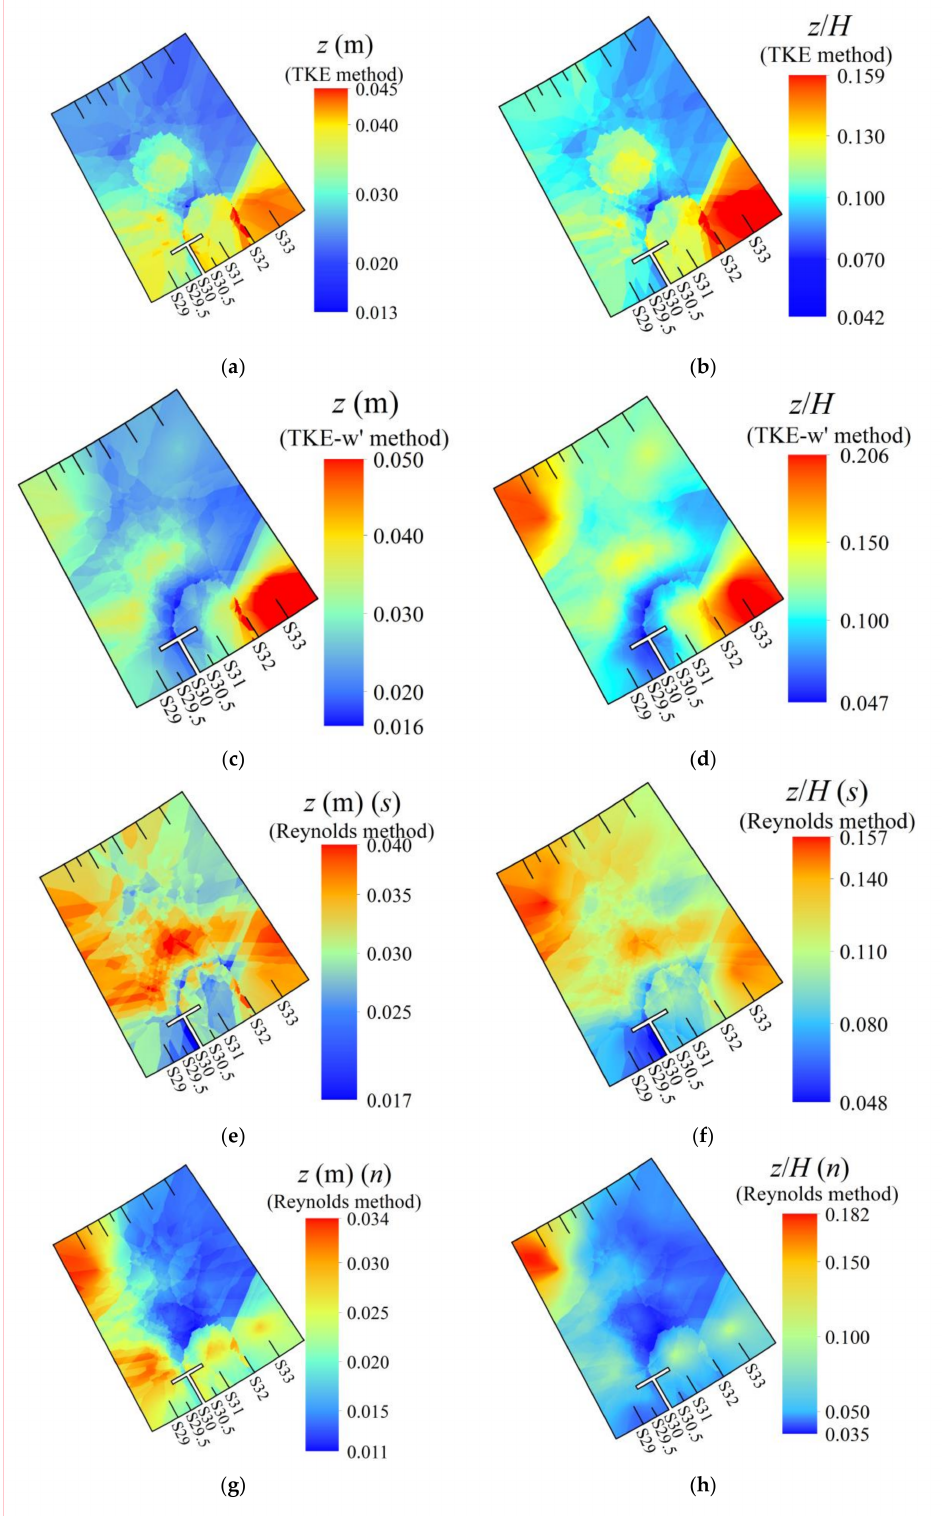
Figure 10. Peak-value heights near the groyne: ( a , b ) TKE method; ( c , d ) TKE-w (cid:48) method; ( e , f ) Reynolds method (s); ( g , h ) Reynolds method